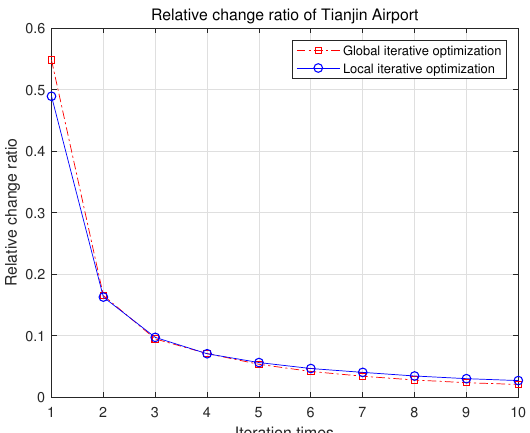
Figure A8. The relative change rate of the whole image and image